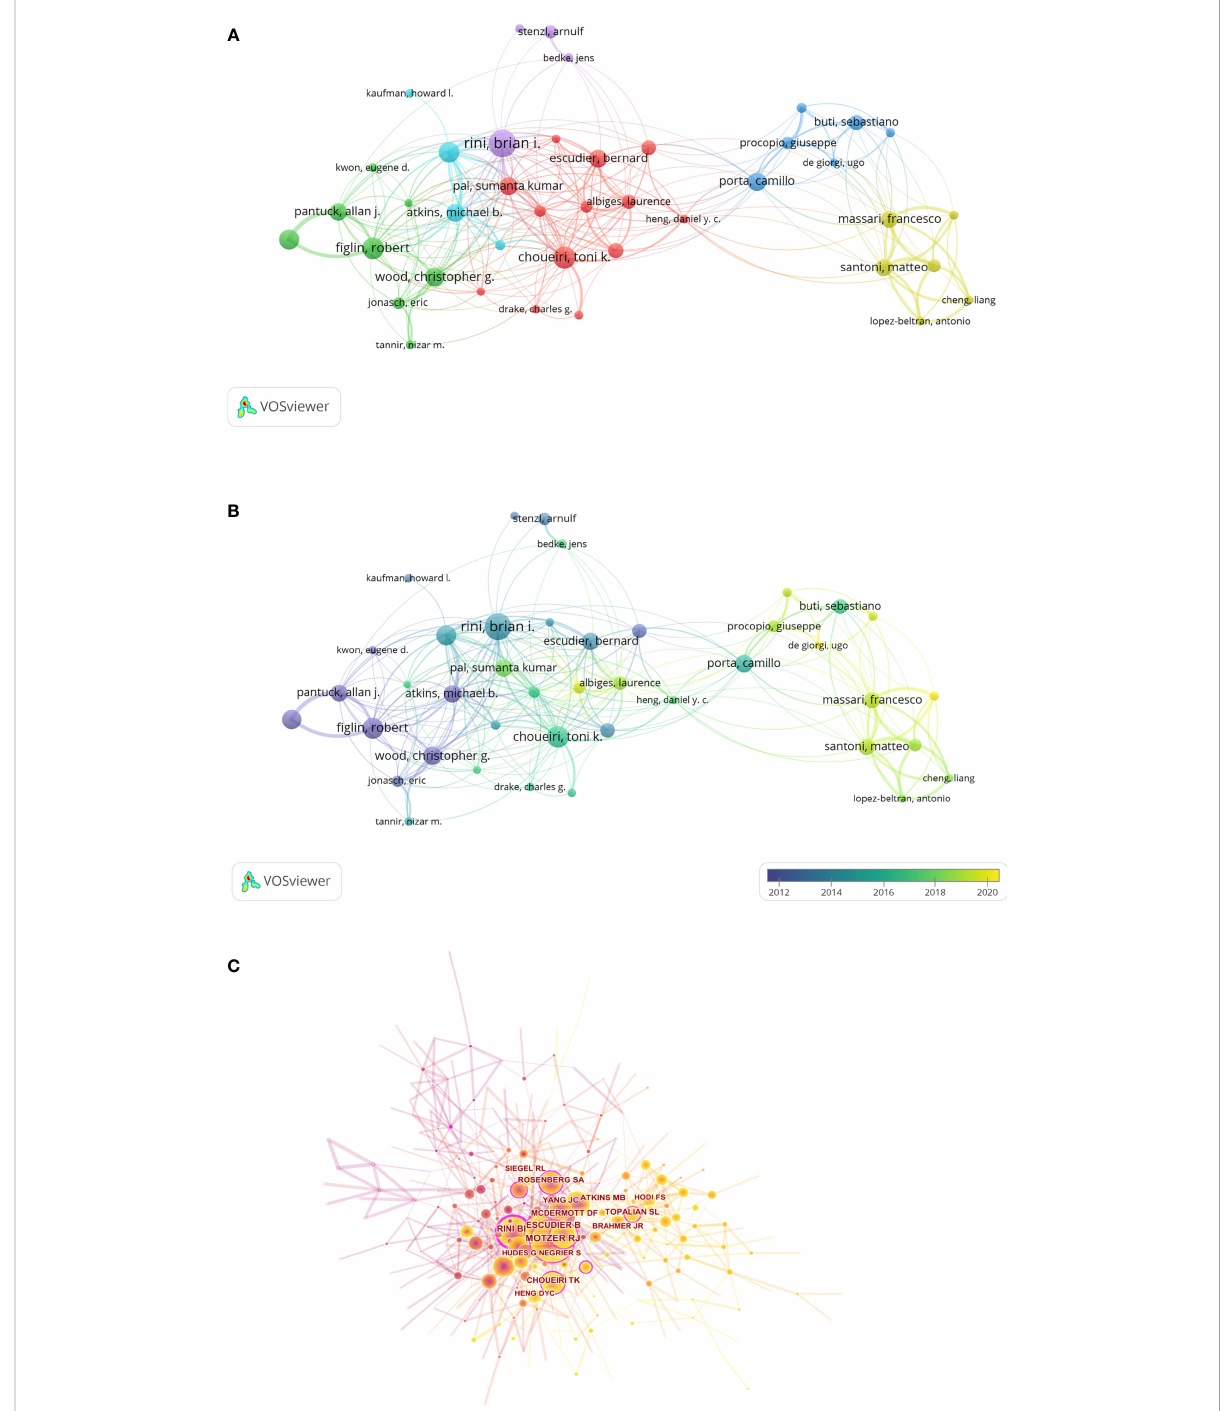
FIGURE 5 The network visualization map (A) and overlay visualization map (B) of author co-authorship analysis conducted by VOSviewer. (C) The visualization map of co-cited authors carried on